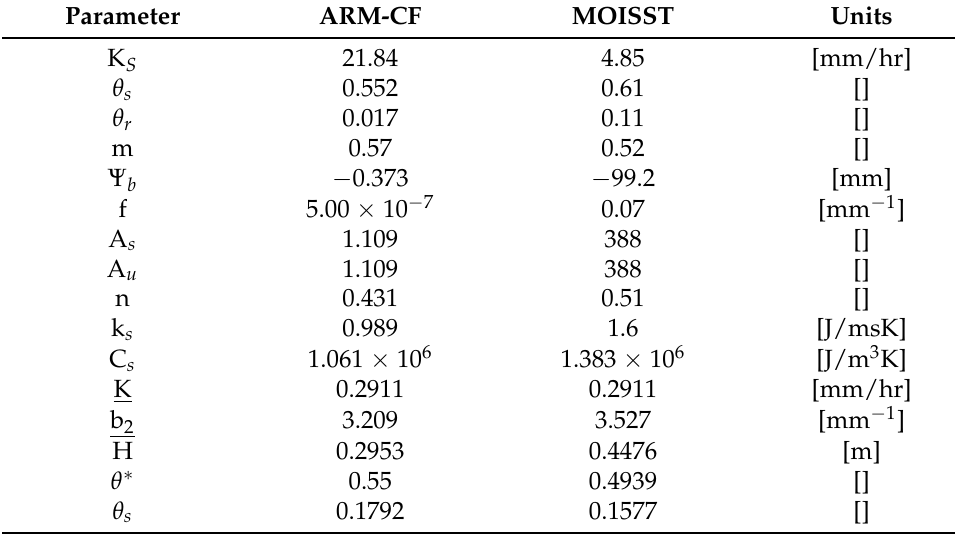
Table 7. tRIBS static soil and vegetation (underlined) parameter values found through calibration at both ARM-CF and